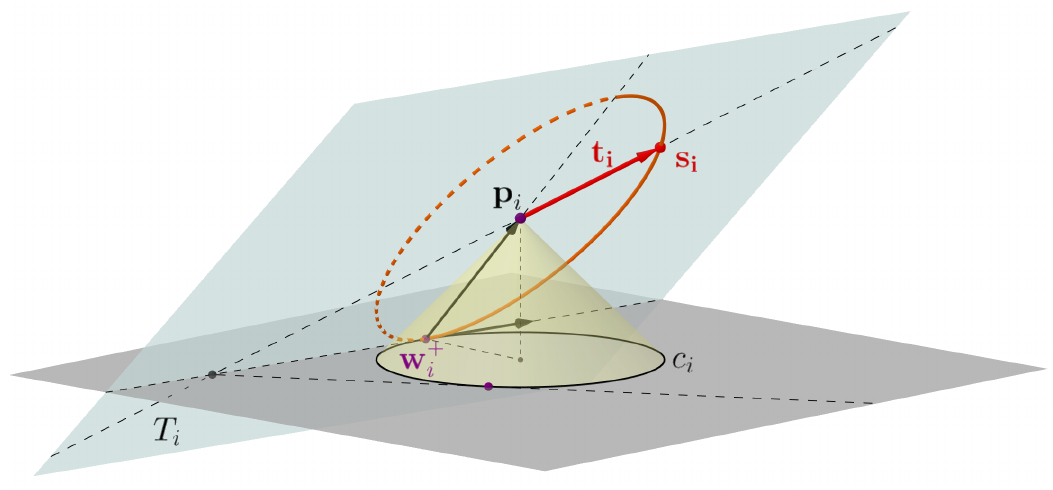
Figure 2. Computation of an appropriate tangent vector. We fix the location of the touching point w + user the freedom to choose the endpoint of the tangent vector t i along a